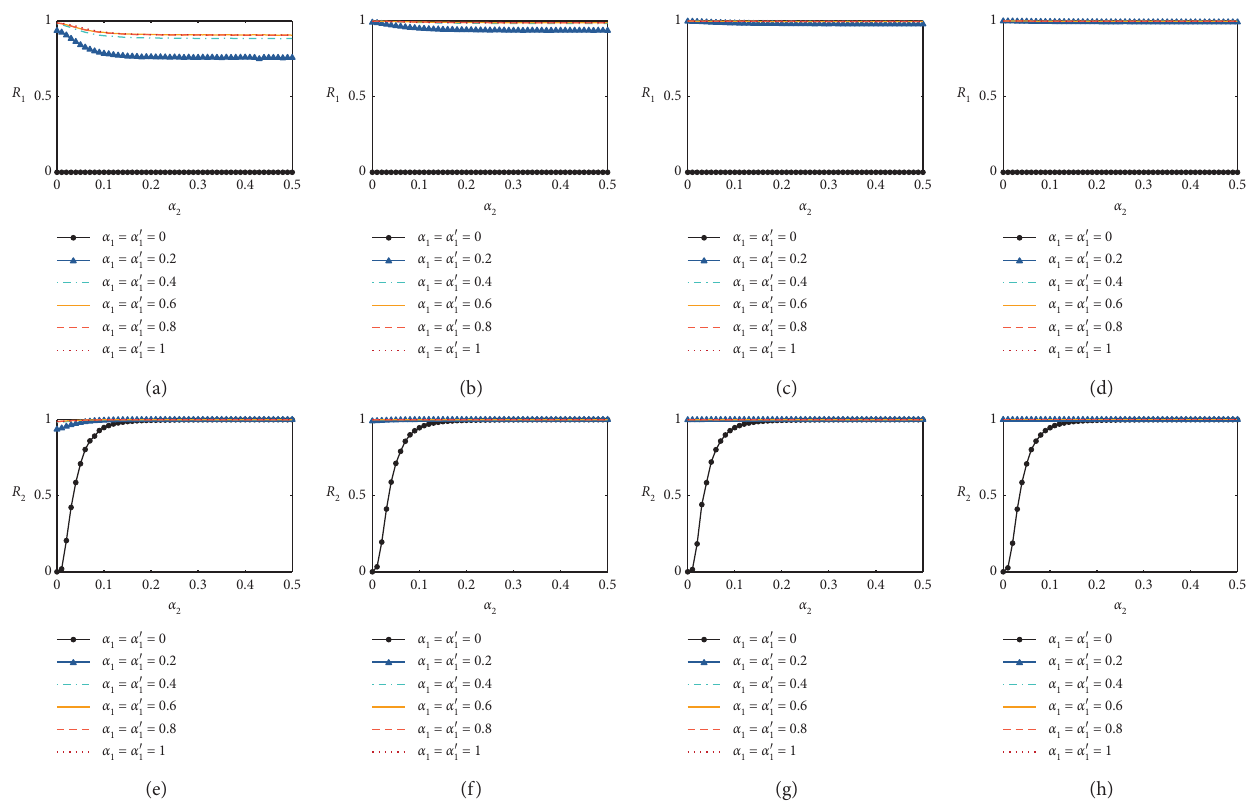
and information spreading size R versus computer virus transmission probability λ 1 2 � 0 . 4, (c) λ � 0 . 6, and (d) λ � 0 . 8. R versus λ with (e) λ 2 2 2 2 1 � c � 0 . 2 and λ � 0 . 8. 1 2 2